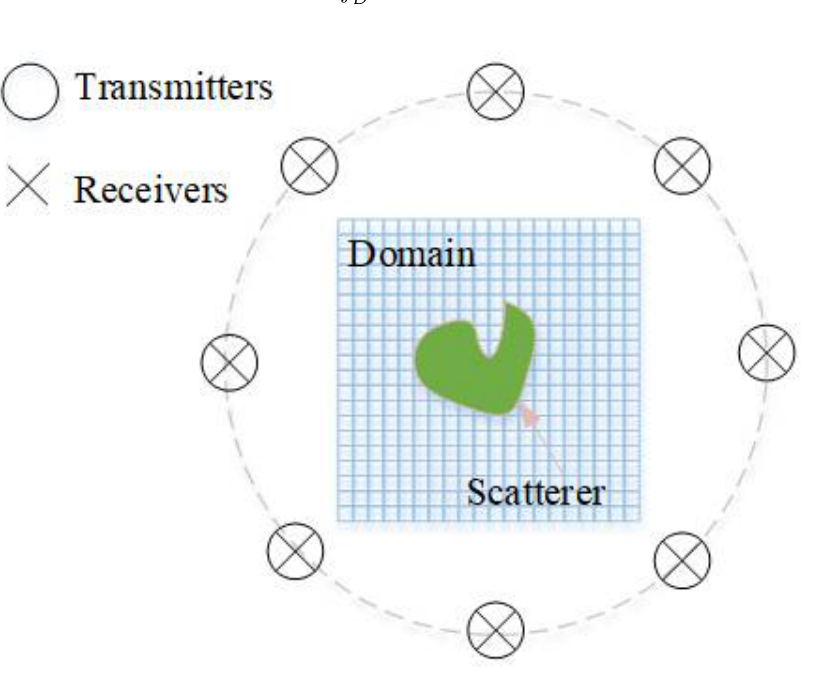
Figure 2. Inverse scattering imaging model.